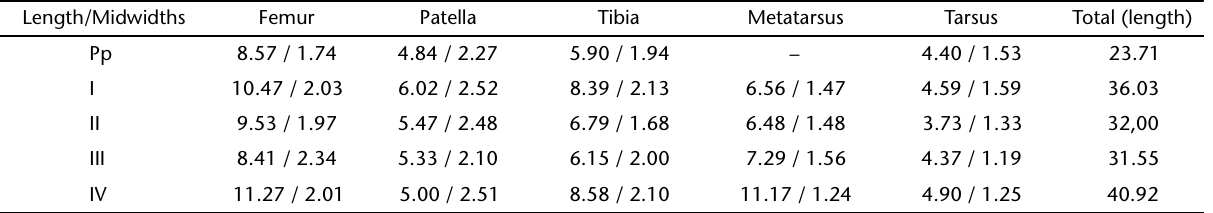
Table III. Vitalius nondescriptus comb. nov. Female MZSP 465351 from Ouro Preto, state of Minas Gerais, Brazil. Length and midwidths of right legs and palpal segments. Length/Midwidths